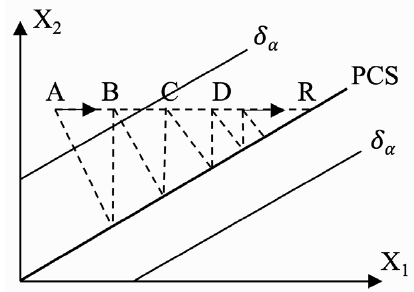
Figure 3. Schematic diagram of data reconstruction.